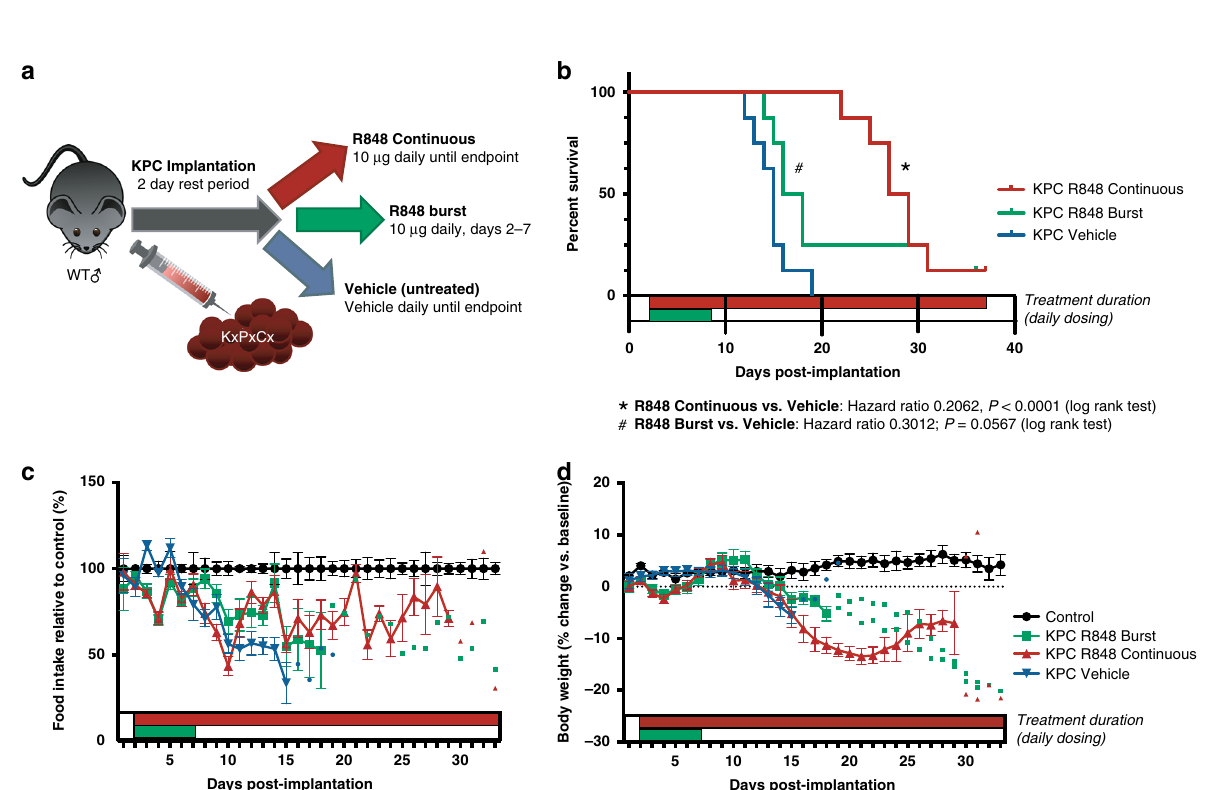
Fig. 5 Continuous R848 monotherapy extends survival in allografted PDAC. Experimental design ( a ), Kaplan-Meier curve comparing sham-treated, burst- treated R848, and continuous-treated R848 KxPxCx-engrafted mice compared by log rank test ( b ), food intake relative to sham controls ( c ), and body weight relative to initial measurement ( d ). n = 8/group. Values are depicted as mean ± SEM, unless fewer than three subjects were remaining in a group, for which individual values are